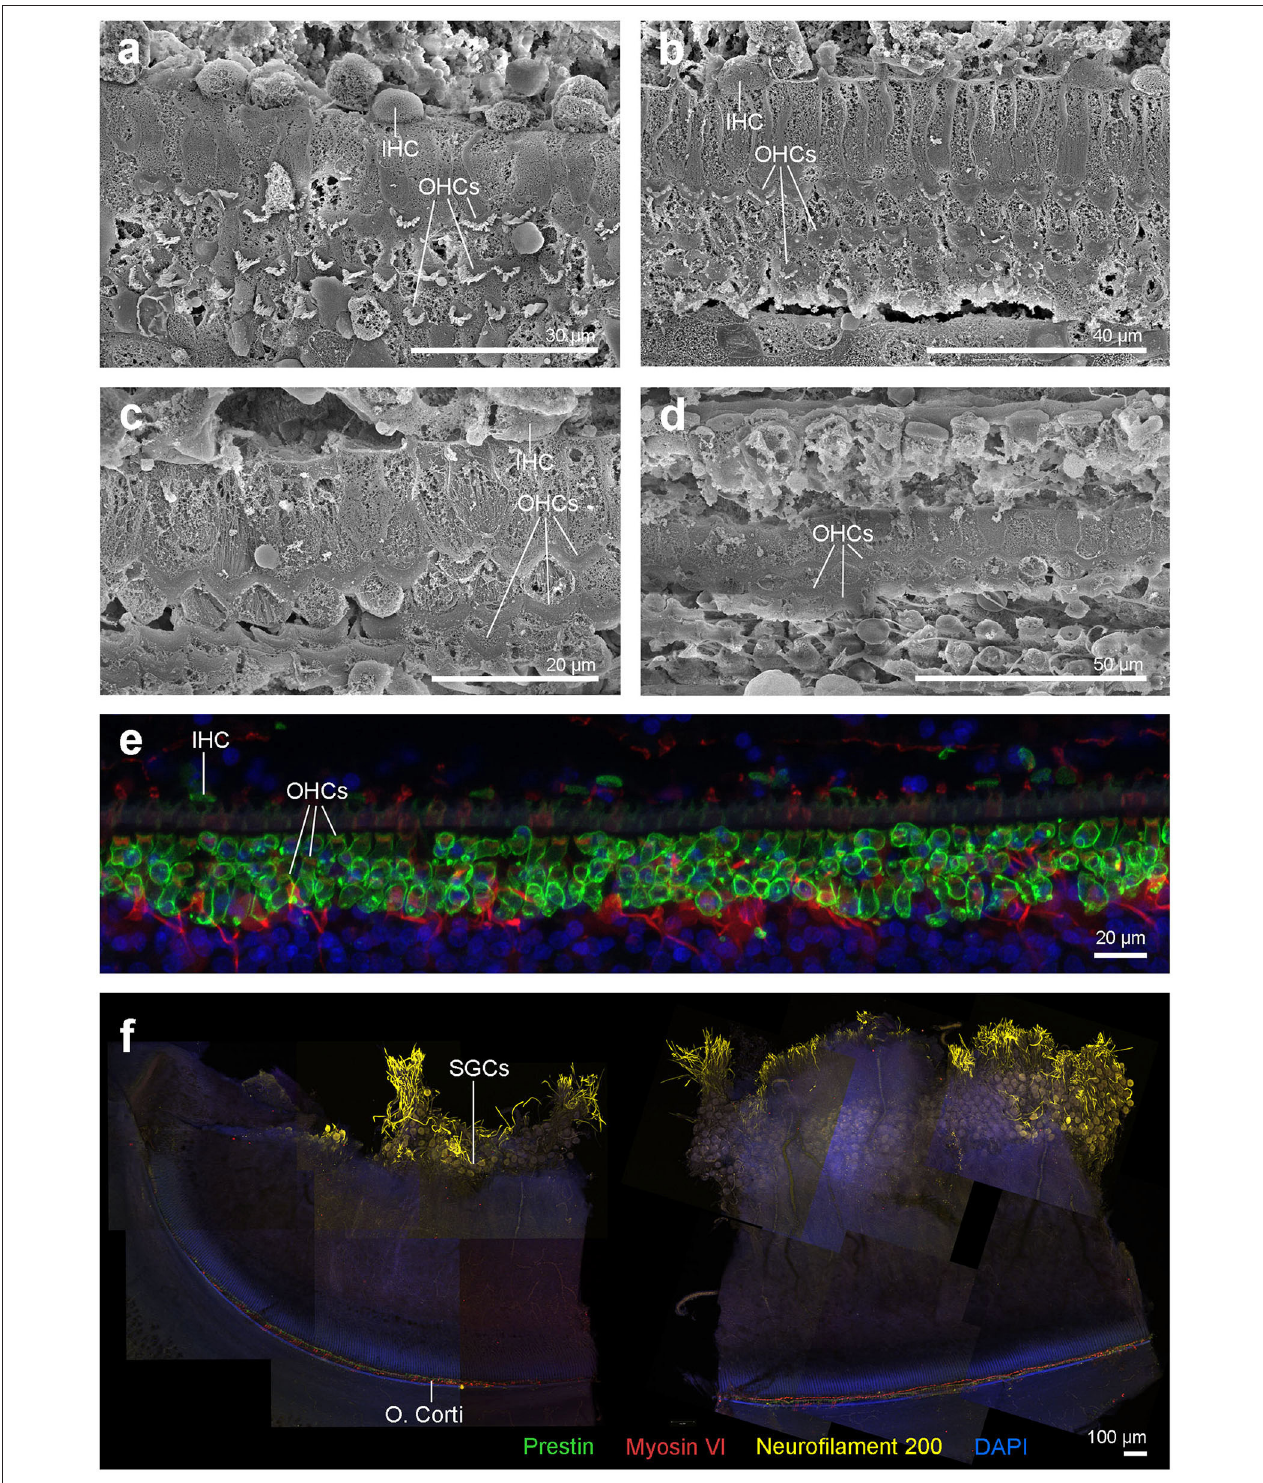
FIGURE 7 | (a–d) Scanning electron micrographs of the left cochlea from the beluga Aurora. Organ of Corti features three rows of outer hair cells (OHCs) and one row of inner hair cells (IHCs) in the upper (a) and lower (b) apical turn, upper (c) and lower (d) basal turn. (e,f) Right cochlea from the beluga Aurora. Immunofluorescence images of the middle turn (e) and hook or most basal part of the right cochlea. (f) The beginning of the hook is located at the left the image, which is the region of the cochlea where the highest frequencies are encoded. Flat preparations of the cochlea were incubated with anti- prestin (green), anti-myosin VI (red), anti-neurofilament 200 kD (yellow) antibodies and DAPI (blue). SGCs, spiral ganglion